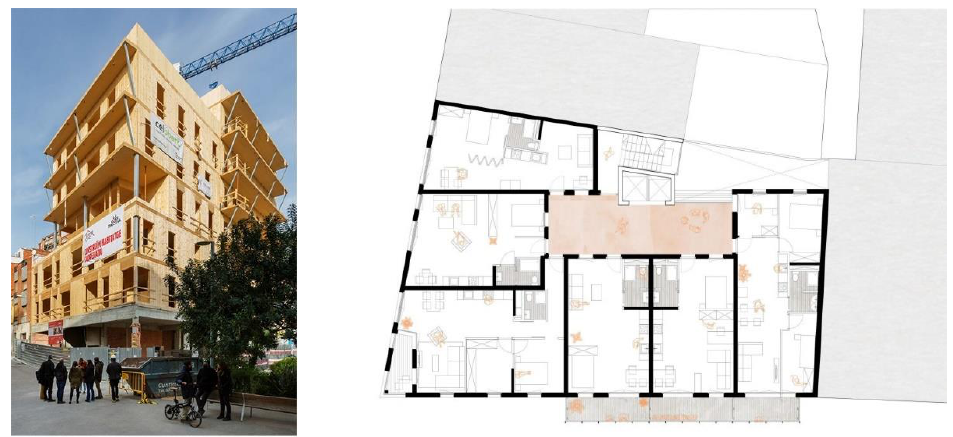
Figure 7. Cirerers under construction and typical plan for construction tender. Source: Plan, courtesy of Celobert; image courtesy of Celobert and Gifré de Peray.